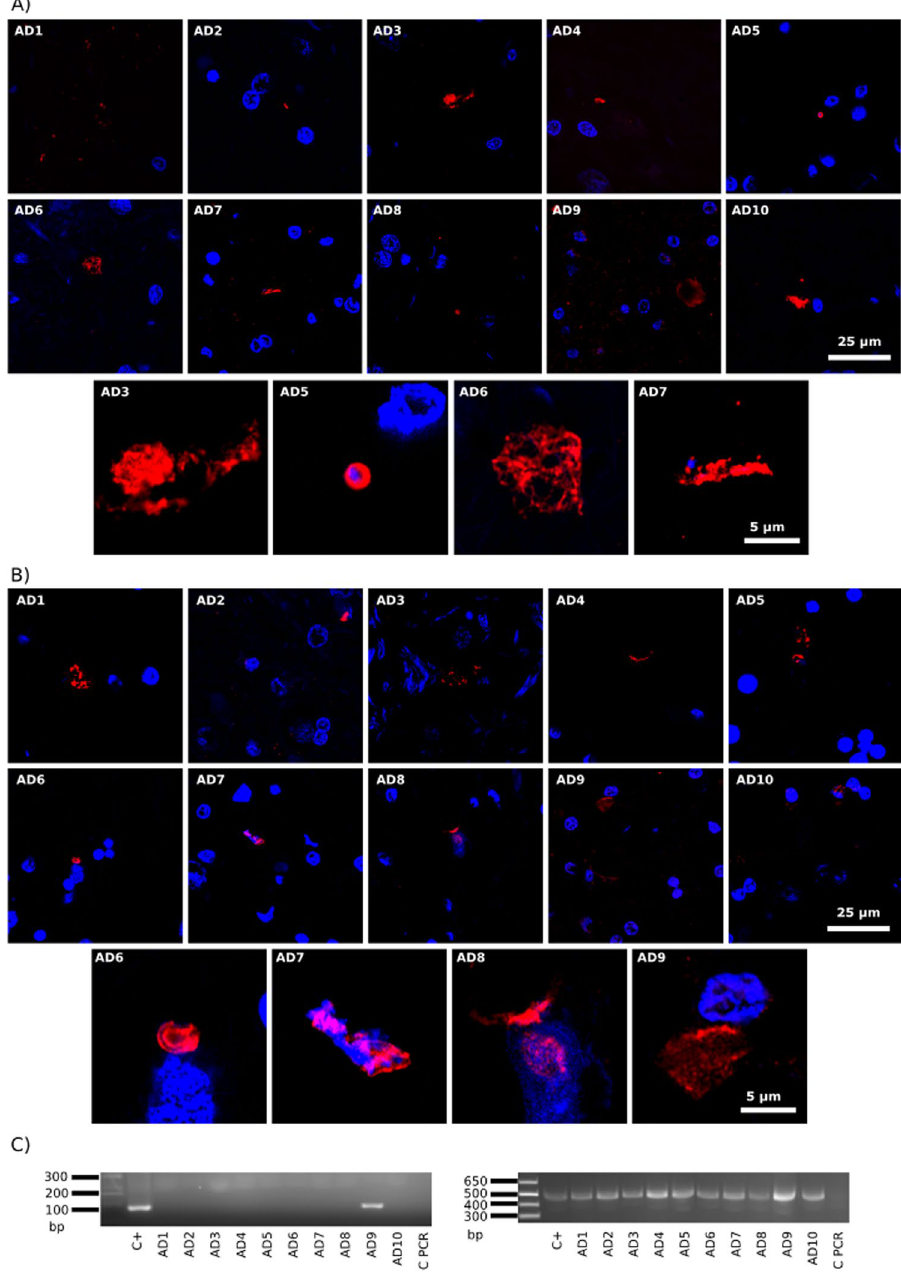
Figure 1. Immunohistochemistry of HSV-1 proteins in brain sections from ten AD patients and PCR analysis of HSV-1 DNA. Entorhinal cortex/hipoccampus (ERH) sections from ten AD patients. Panel A: samples were immunostained with mouse monoclonal antibody (1:50) against HSV ICP0 (green), and rabbit polyclonal antibody (1:100) against C. albicans (red). The different patients are numbered from AD1 to AD10 and one field is shown for each patient. In addition, four selected sections are shown at higher magnification below the ten AD patients. Panel B: samples were immunostained with mouse monoclonal antibody (1:50) against HSV-1 ICP5 (green) and rabbit polyclonal antibody (1:100) against C. albicans (red). DAPI staining of nuclei appears in blue. Scale bar as shown in the figure. Panel C: PCR analysis of HSV-1 and β -globin DNA in frozen brain tissue from ten AD patients. Left panel: Nested PCR analysis of ten ERH samples using primers that amplify HSV-1 glycoprotein D gene. The primers employed were HSV-1 FE (forward external) and HSV-1 RE (reverse external) for the first PCR and primers HSV-1 FI (forward internal) and HSV-1 RI (reverse internal) for the second PCR. As positive control, DNA from HSV-1-infected HeLa cells was used. Right panel: PCR analysis using β -globin oligonucleotide primers. As positive control, DNA extracted from HeLa cells was used. Control PCR: PCR without DNA. DNA markers are indicated on the